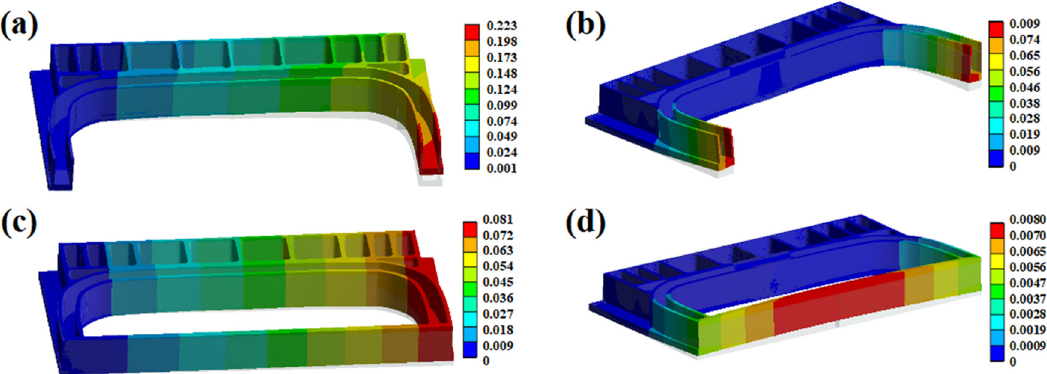
Figure 10: Simulation results of equivalent bending sti ff ness for Specimen A in the X direction ( a ) and the Y direction ( b ) and for Specimen B in the X direction ( c ) and the Y direction ( d )